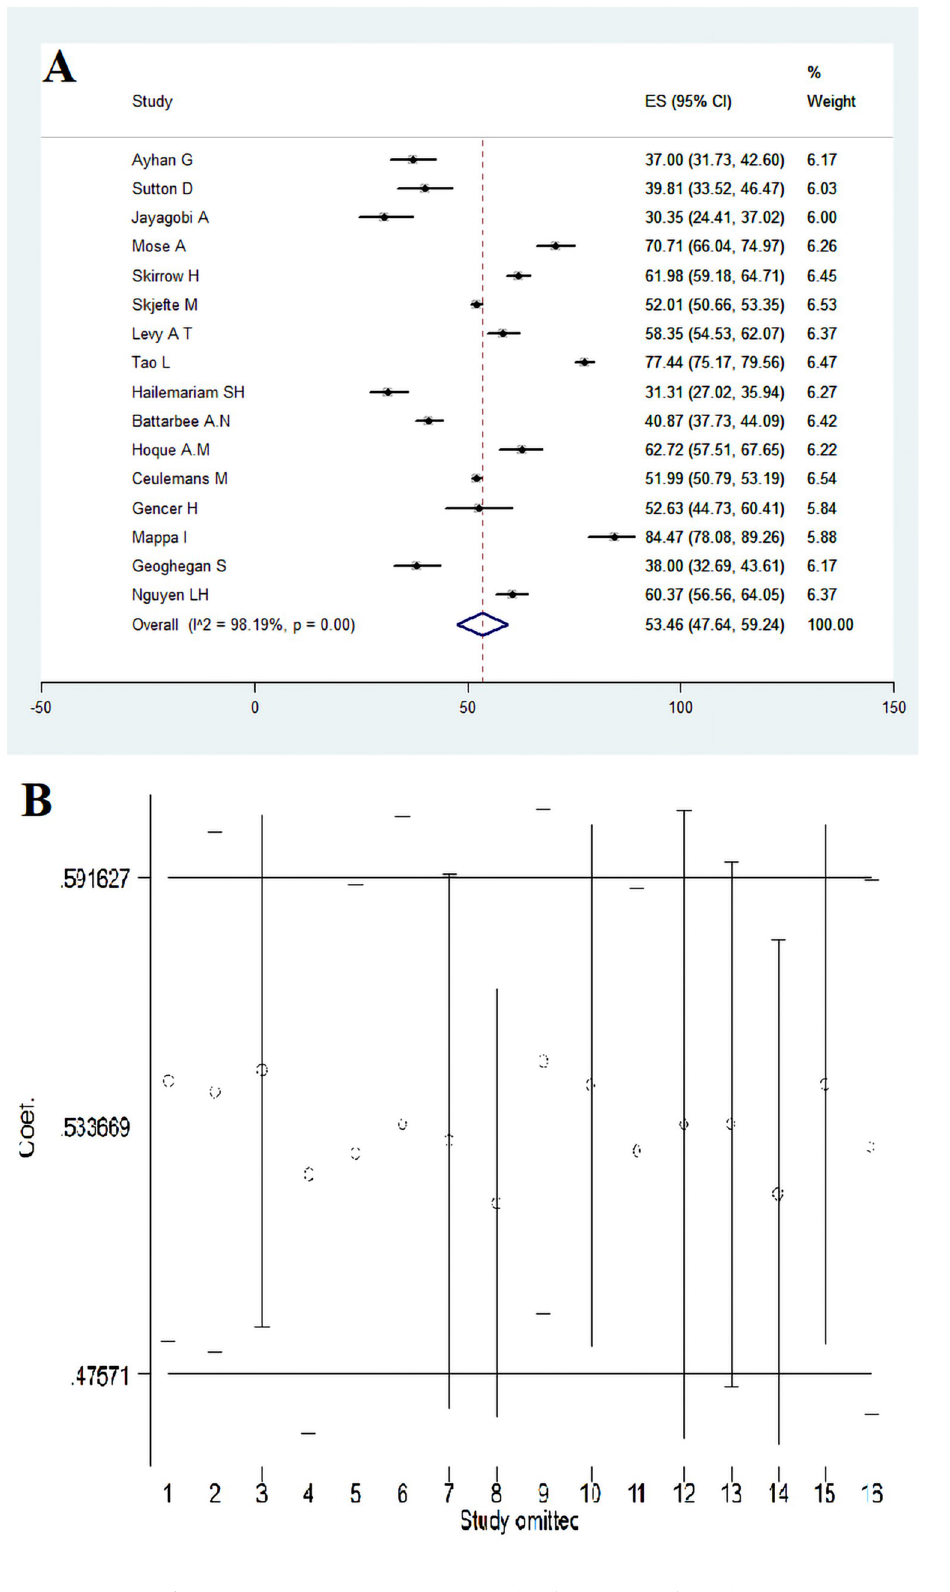
Fig 2. Acceptance of COVID-19 vaccine in pregnant women (A) and sensitivity analysis (B). https://doi.org/10.1371/journal.pone.0272273.g002 PLOS ONE | https://doi.org/10.1371/journal.pone.0272273 September 28,